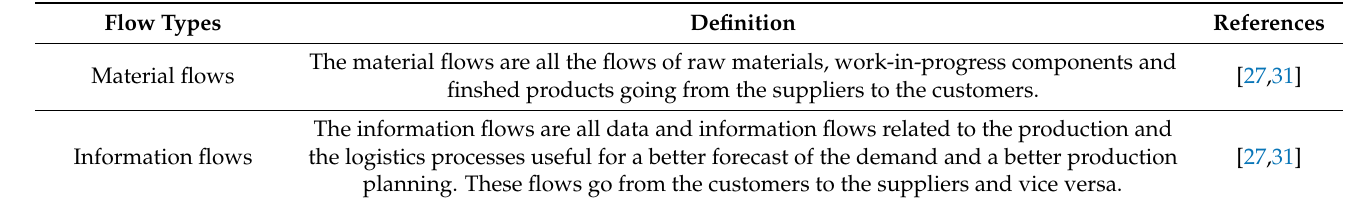
Table 2. Flow types.